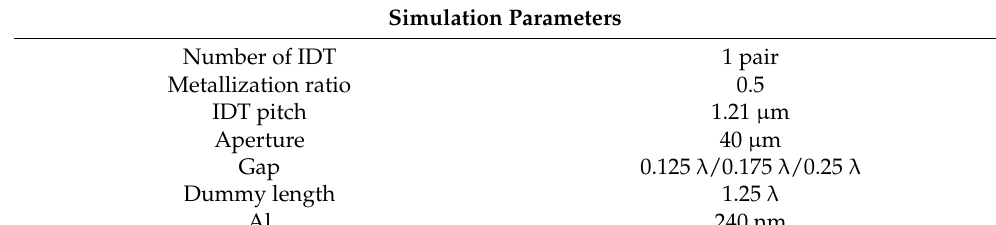
Table 1. Simulation parameter table.